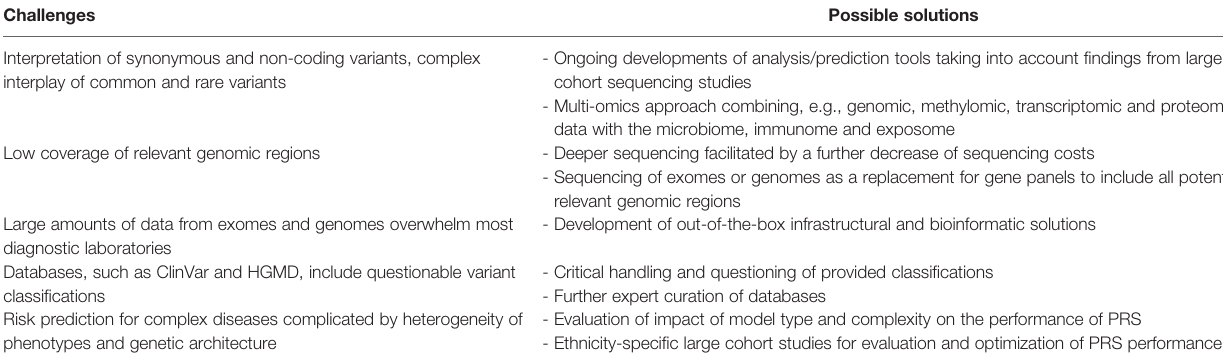
TABLE 1 | Challenges and possible